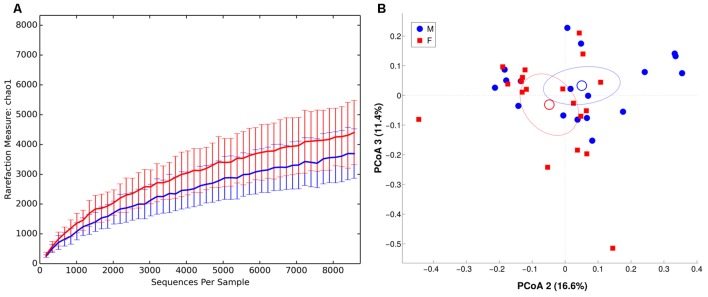
α and β diversity in MAM microbiota. Females are in red, whereas males are in blue. (A) α-diversity plot of MAM microbiota for chao1 metric. Differences are statistically significant (p < 0.05). (B) PCoA according to unweighted Unifrac distance, showing a significant (p = 0.049) separation between the two groups.